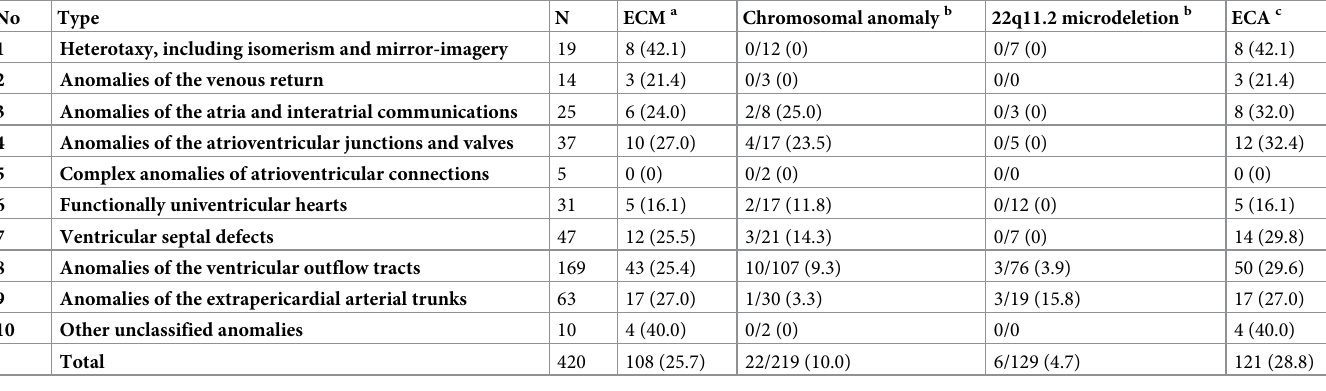
Table 5. Prevalence of extracardiac anomalies by type of congenital heart disease (live birth